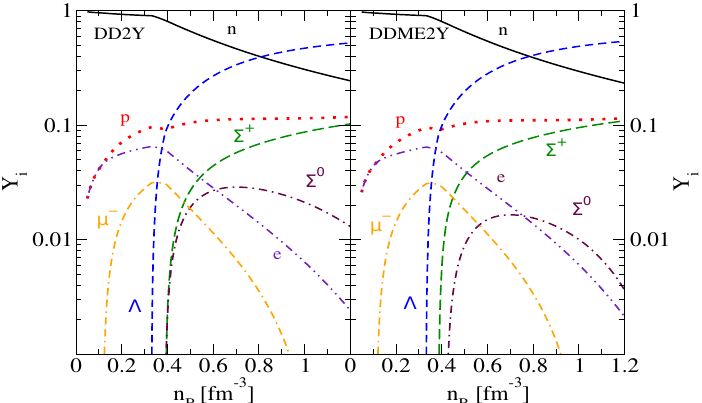
Figure 3. Particle composition (Y i ) as a function of the baryonic density of DD2Y model [122] ( left panel ) and DD2MEY model [122] ( right panel ). See text for